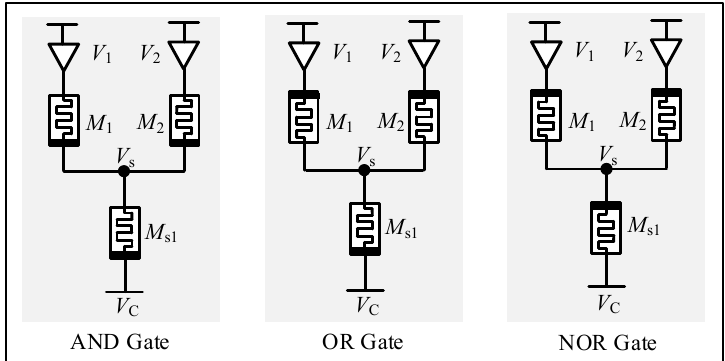
Figure 5. The writing circuit for the implementation of other ternary logic gates.